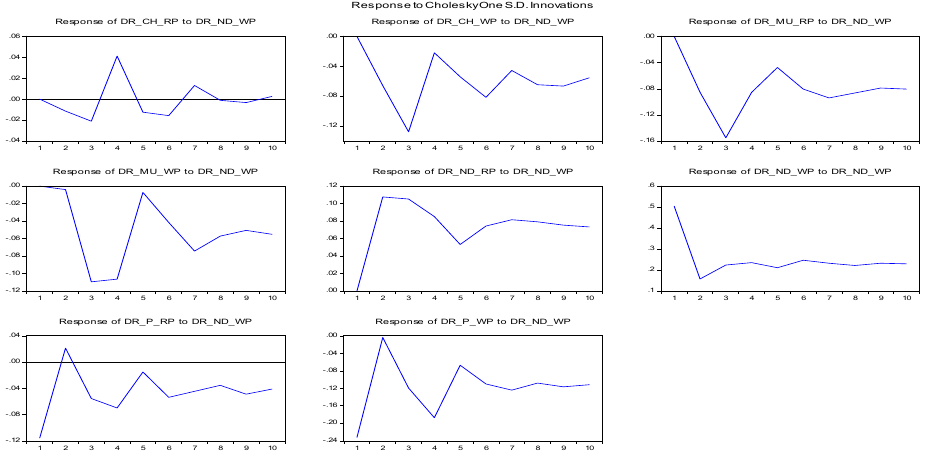
the prices, corroborating the information given in Table 1.